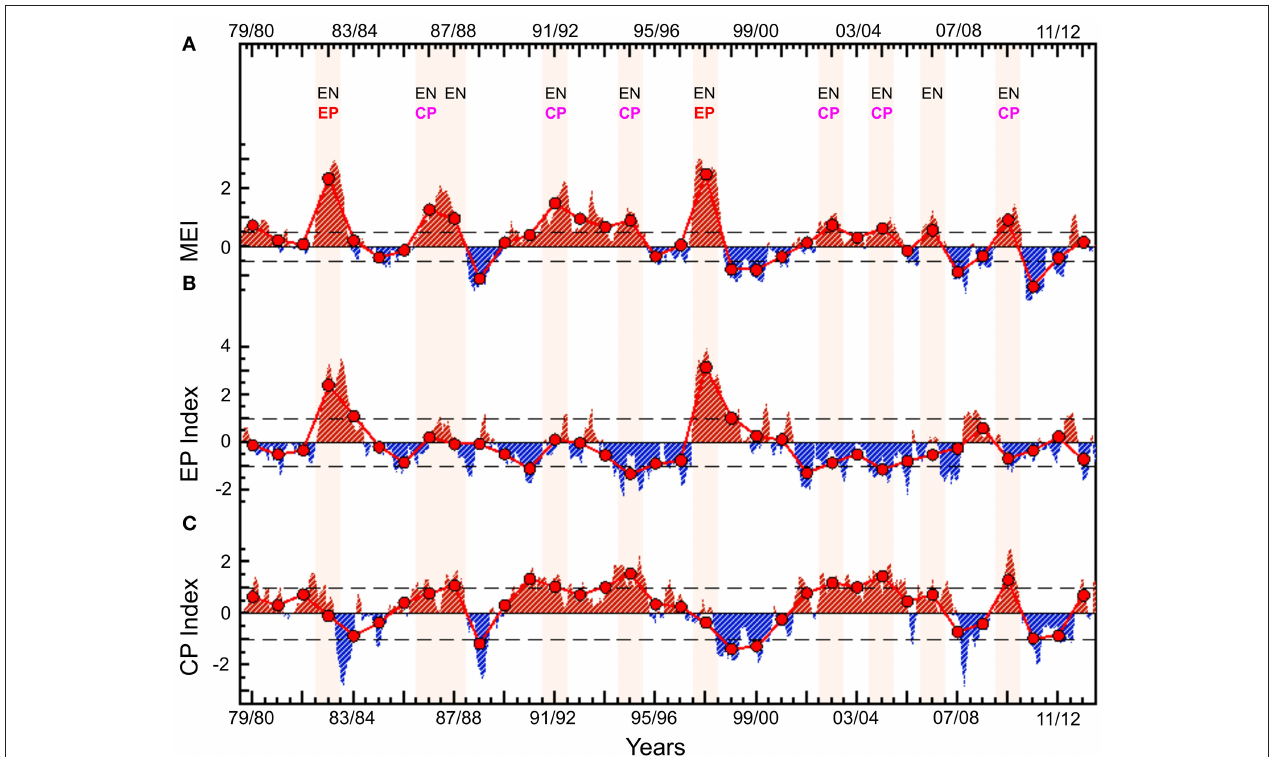
FIGURE 1 | Climate indices of El Niño events during the period 1979–2014. Monthly anomalies of (A) Multivariate ENSO Index; (B) Eastern Pacific El Niño Index; and (C) Central Pacific El Niño Index. Annual mean anomalies (thick red line and large dots) were calculated by averaging the monthly anomalies over the periods from June (of year t ) to May (of year t + 1 ). Classification of El Niño as EP and CP is based on Radenac et al. (2012) and Yu et al. (2012). EN, El Niño, EP, Eastern Pacific, CP, Central